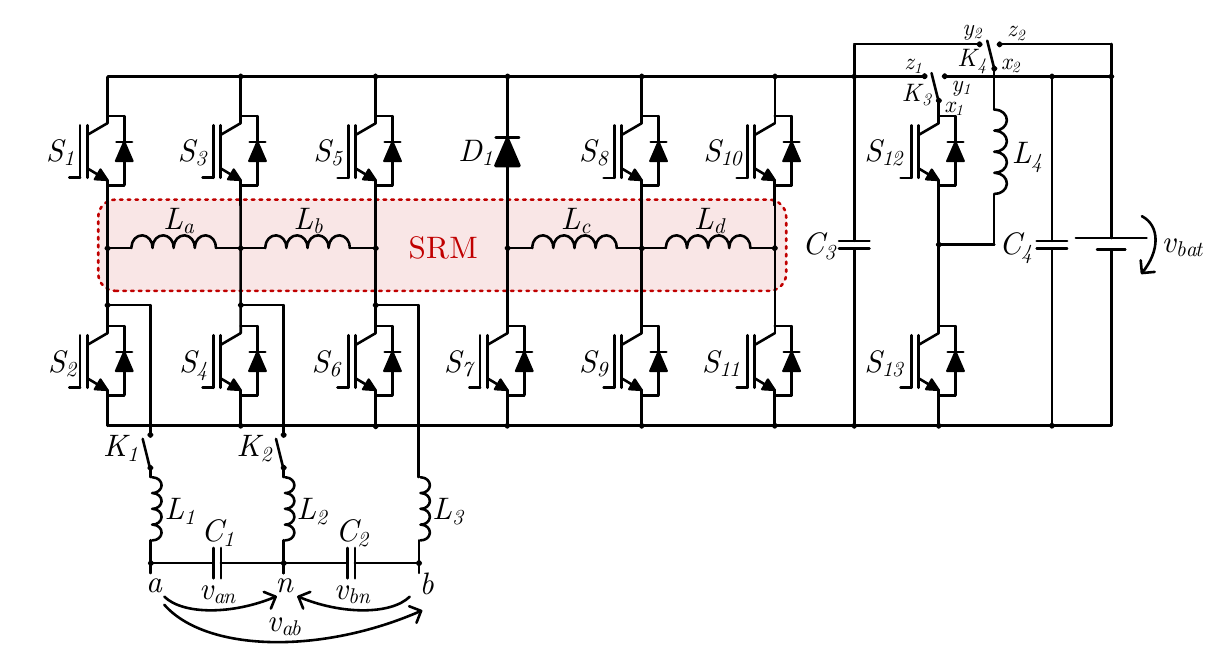
batteries ( K 4 , K 5 ), making it possible to use the former, the latter or a combination of both,